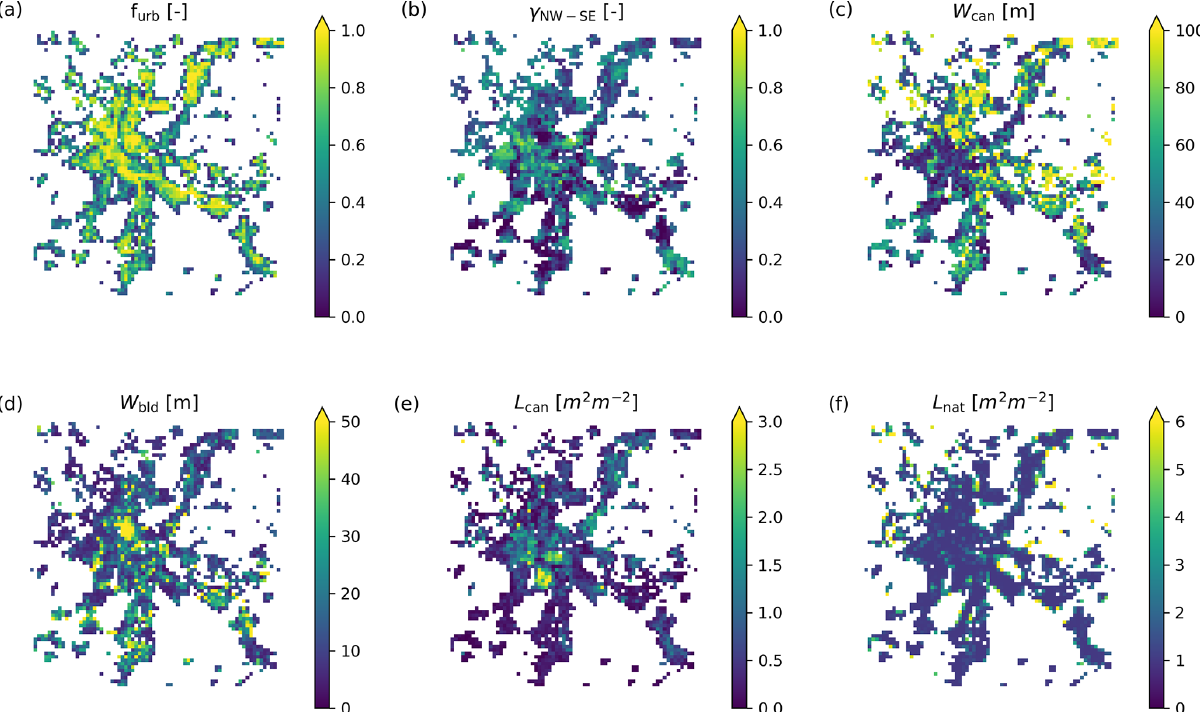
Figure 4. Urban canopy parameters derived for the model domain: (a) urban fraction, (b) canyon fraction along the NW–SE direction, (c) average canyon width, (d) average building width, (e) leaf area index due to street trees and (f) leaf area index due to vegetation outside the urban canopy. Further details about the variables are given in Table A1. Only urban grid cells ( f urb > 0 . 1) are shown.